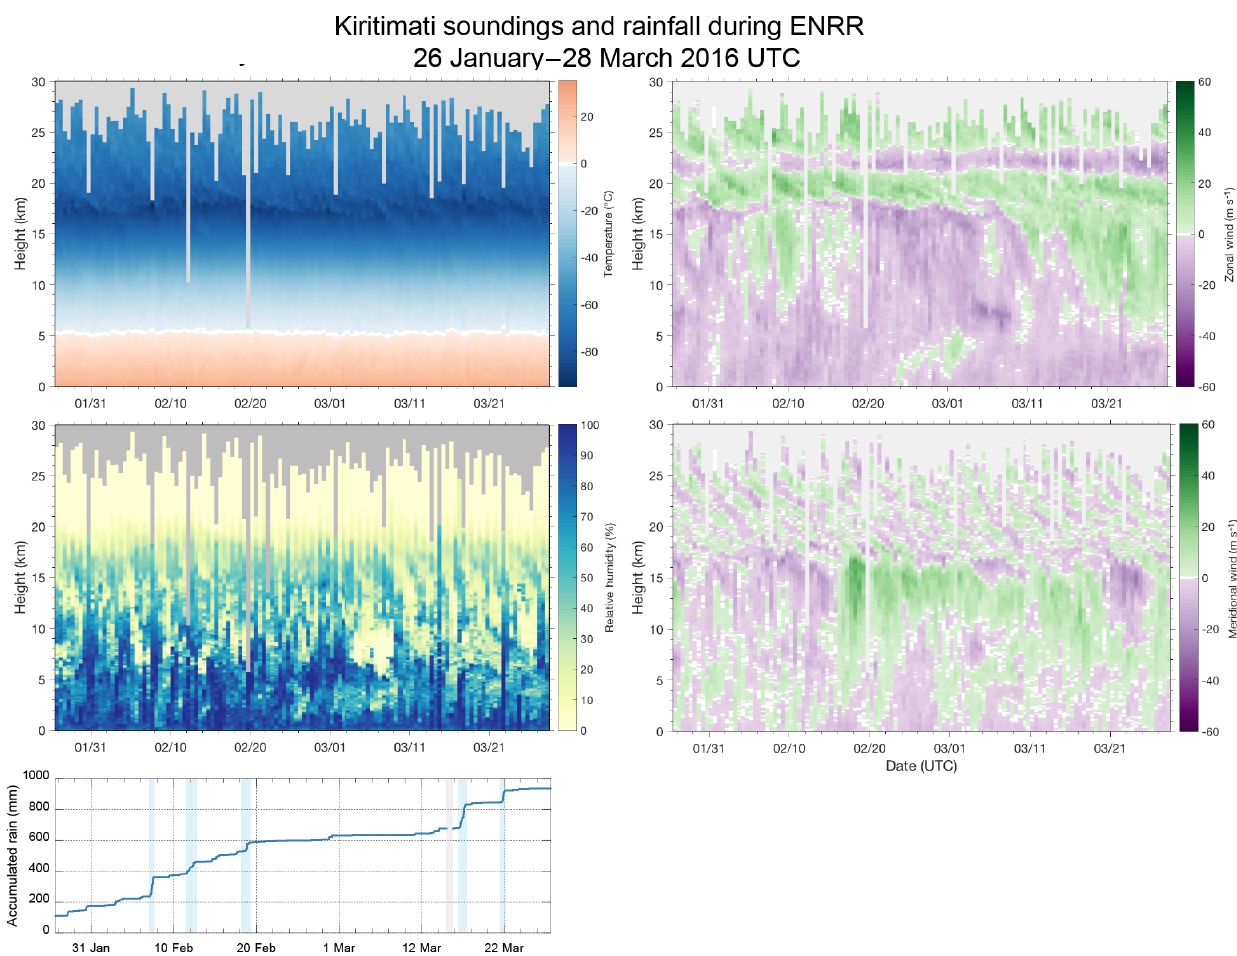
Figure 8. Vertical time–height sections of the temperature, relative humidity, and wind components measured by radiosondes launched from Kiritimati, together with the accumulated precipitation during the deployment (middle panel, shown only during the time range matching the time–height sections). Data from each sounding have been interpolated to a 25m vertical grid before plotting and stretch along the x axis to completely fill the time between launches, while grey shading indicates no available data. The time between the penultimate and final launches is duplicated in the plotting of that final launch. In the accumulated precipitation panel, light blue bars indicate the times of the major rain events that occurred during the sounding observation interval; the initial major rain event occurred before the first sounding was launched. Colors from www.ColorBrewer.org by Cynthia A. Brewer, Geography, Pennsylvania State